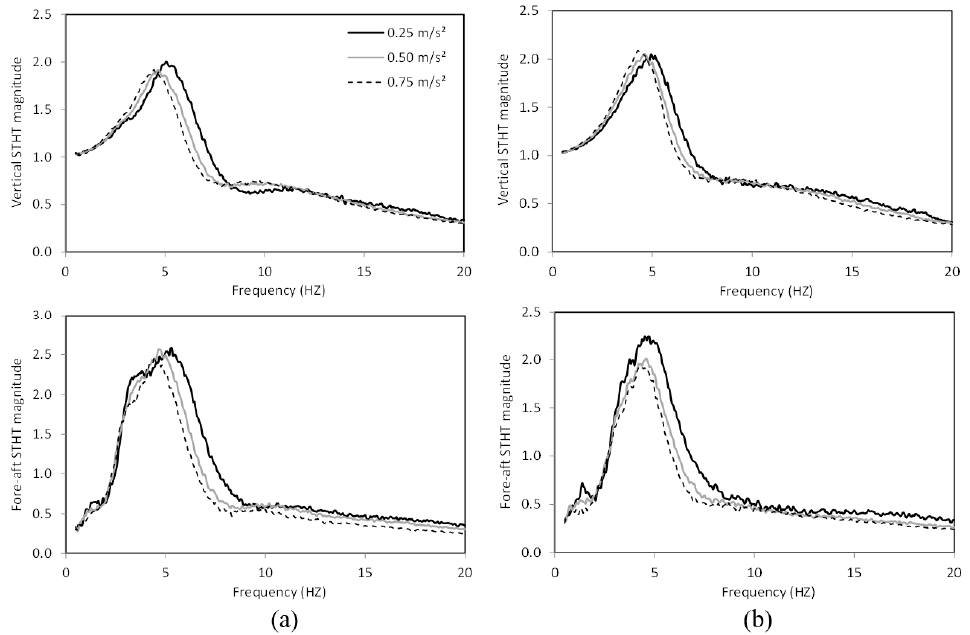
Figure 6. Influence of excitation level on mean STHT magnitude responses of subjects sitting without back support: ( a ) 31 males; and ( b ) 27 females.